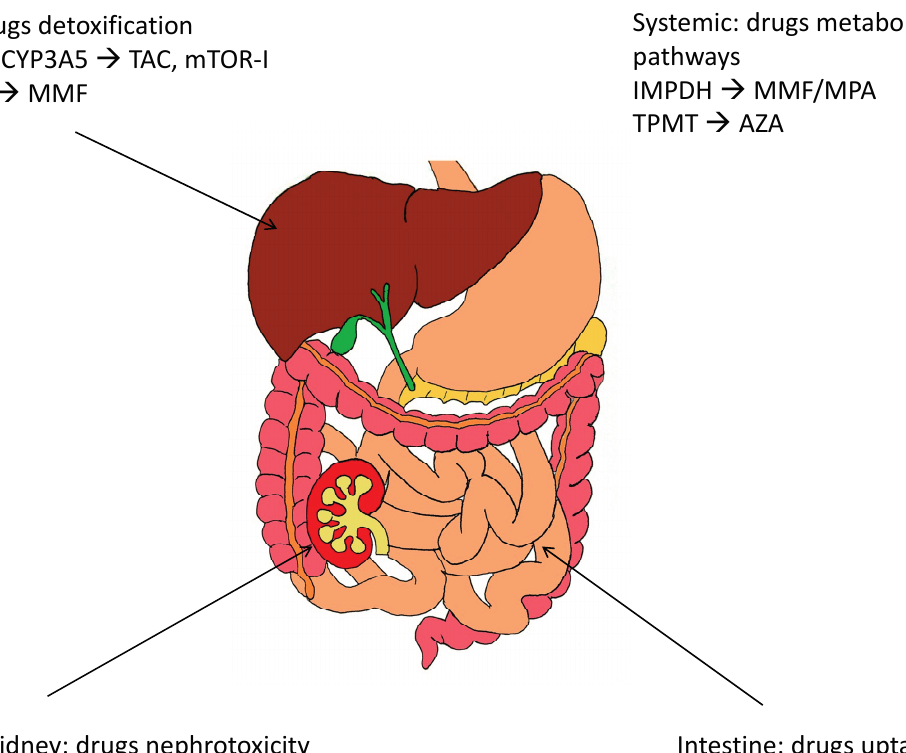
Figure 1. Tissue localization of major polymorphic enzymes involved in metabolism and disposition of immunosuppressive drugs. TAC: Tacrolimus; mTOR-I: mammalian target of rapamycin (mTOR) inhibitors; CsA: Cyclosporin A; MPA: Micophenolic acid; MMF: Mycophenolate mofetil; AZA: